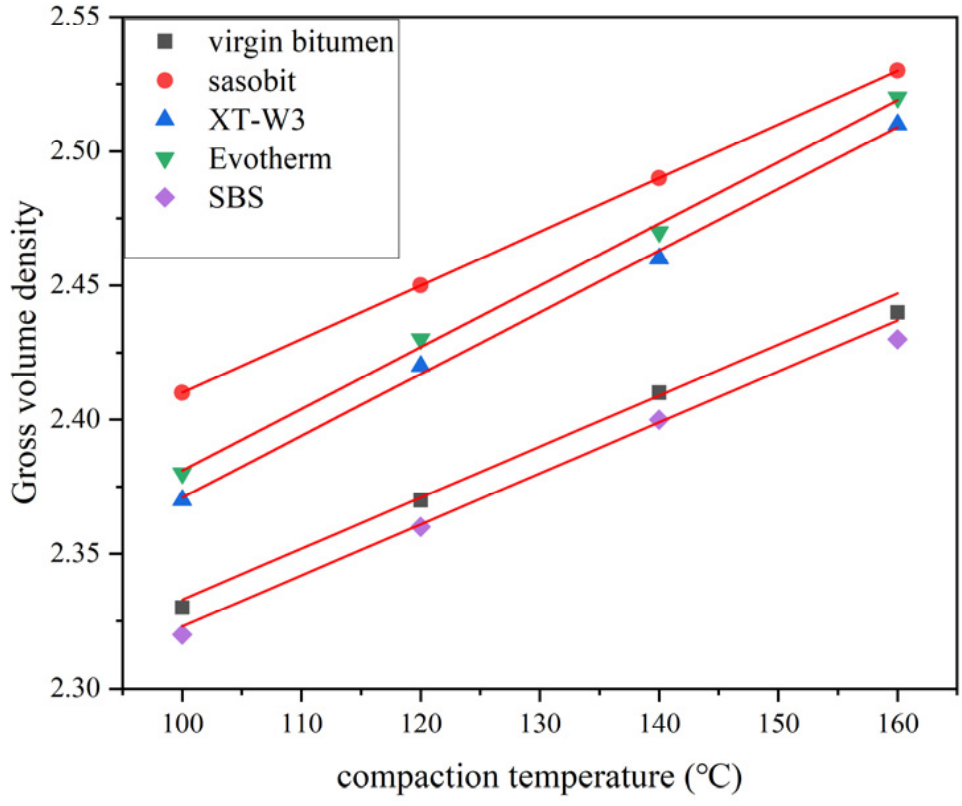
Figure 7. Relationship between gross bulk density and compaction temperature.